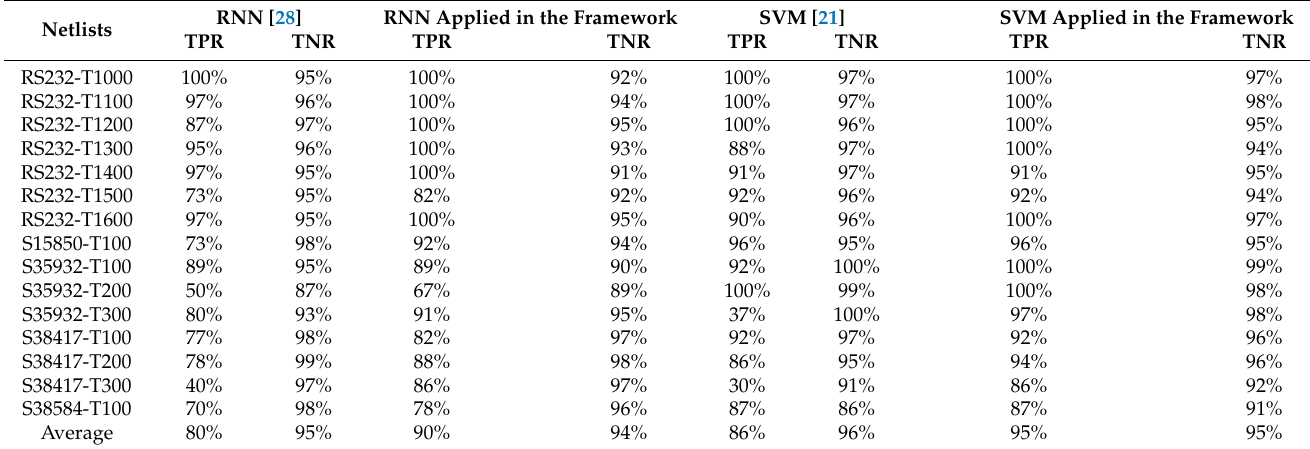
Table 6. Comparison of the original work and our